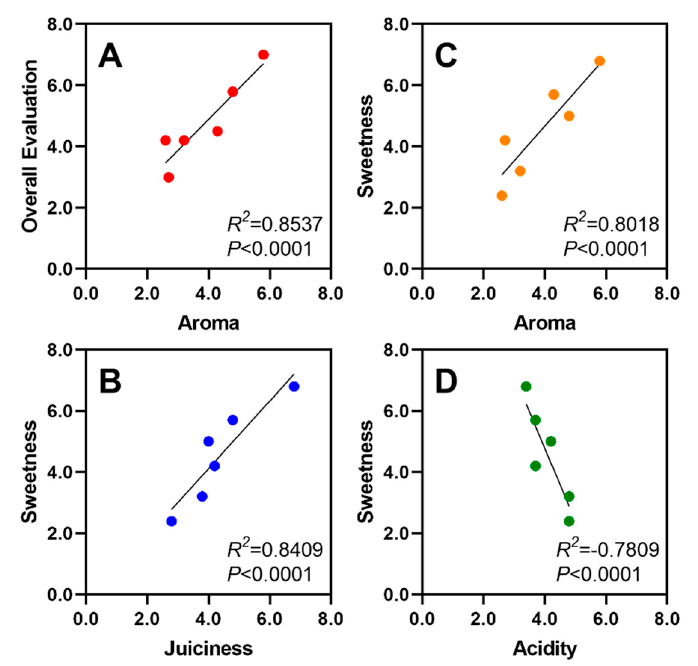
Figure 8. Selected strong relationships between sensory attributes from commercial cultivars evaluated in 2008. Overall evaluation and aroma demonstrate the strongest relationship across sensory data ( A ). Sweetness demonstrated positive relationships with juiciness and aroma ( B , C ). Inversely, sweetness exhibits a negative relationship with acidity ( D ).